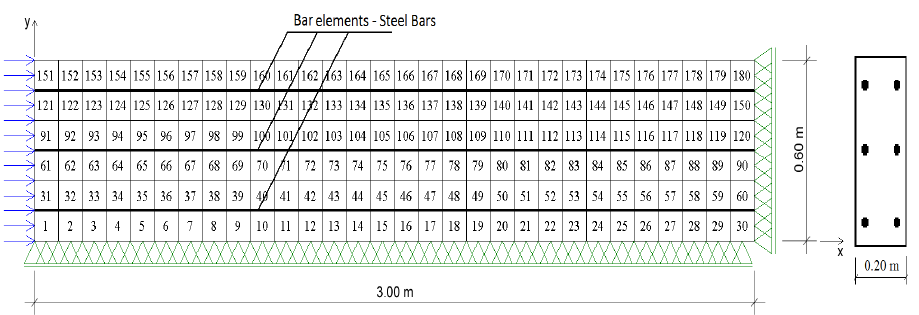
Figure 4. Basic model, Problem domain and finite element mesh.